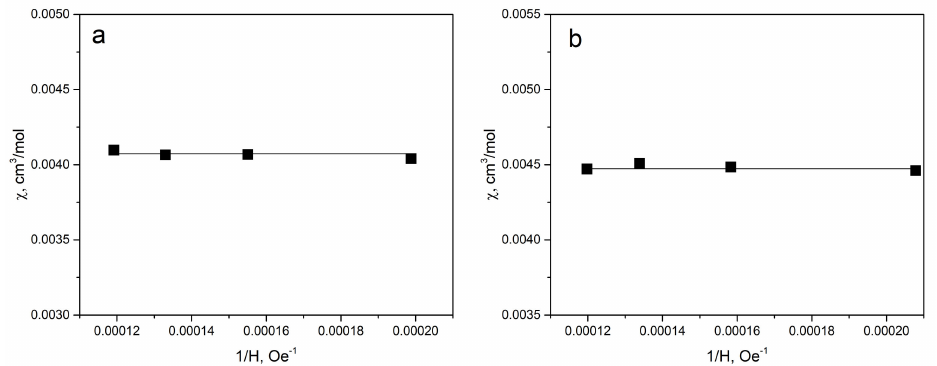
Figure 2. Magnetic susceptibility field dependencies χ (1/H) at T = 300 K: CuCrS 2 ( a ), CuCr 0.99 Dy 0.01 S 2 ( b